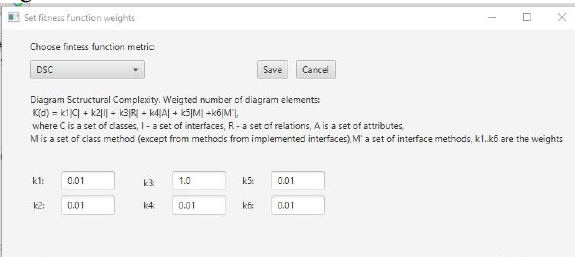
Fig. 14. Performance of the DSC Metric Calculation